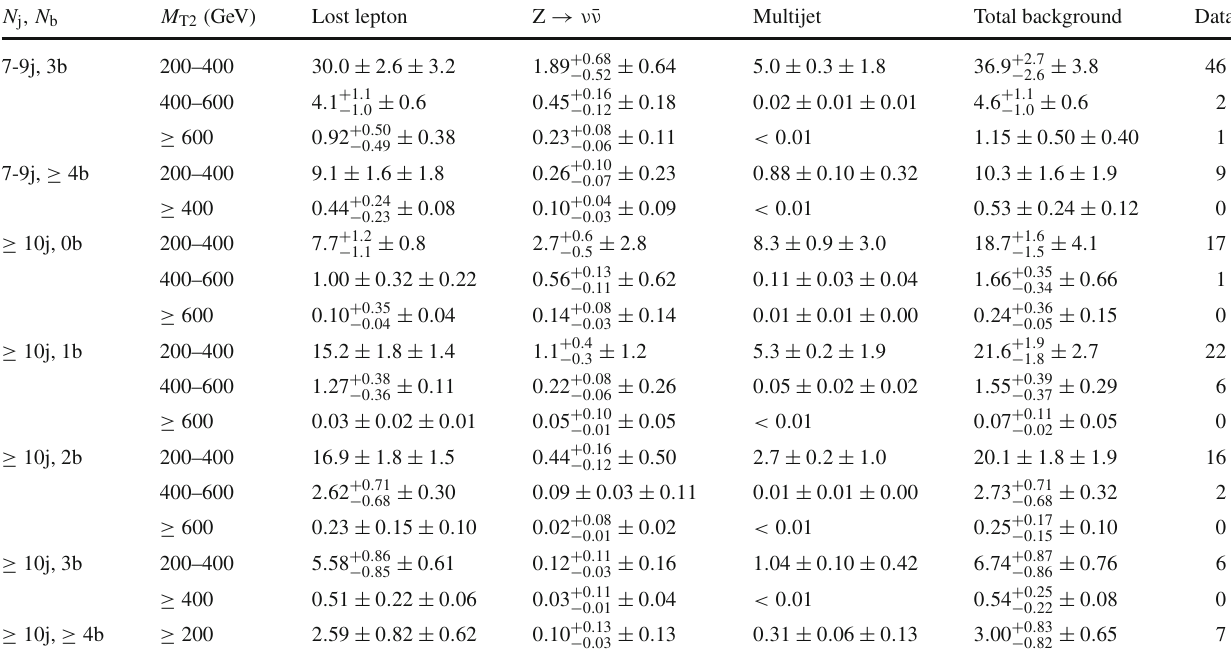
tainty listed is statistical (from the limited size of data control samples and Monte Carlo samples), and the second is